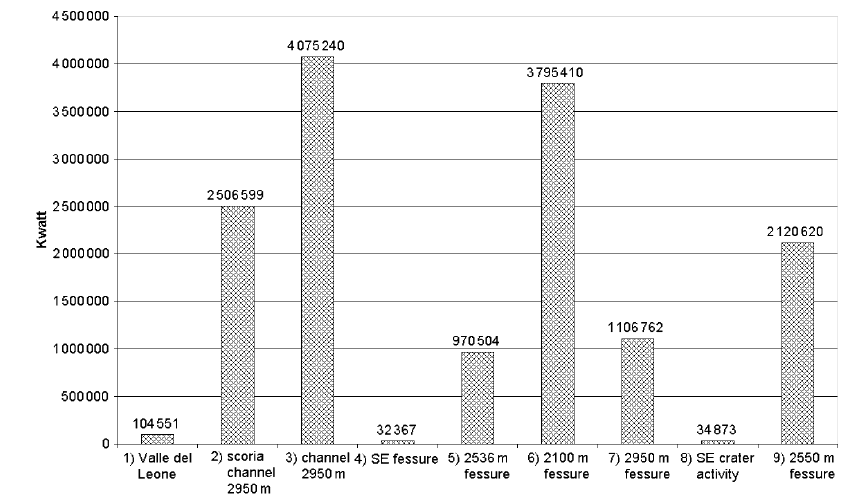
Fig. 4. Energy flux contribution of the distinct active lava flows on 29th July